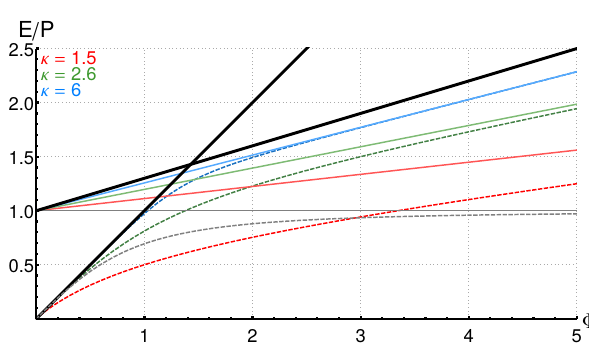
Figure 5. Difference between the actual (solid colored lines) and maximum slope (solid black line) of the supply limit for differ- ent values of κ (red: κ = 1.5; green: κ = 2.6; and blue: κ = 6) and y 0 = 0.3. The maximum slope ( m = y 0 = 0.3) is reached if κ →∞ .